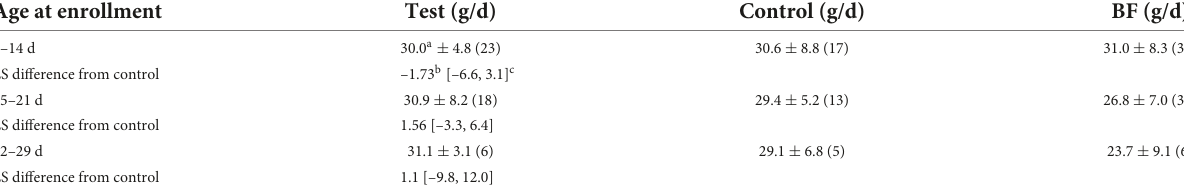
TABLE 5 Weight gain as a function of age at enrollment.